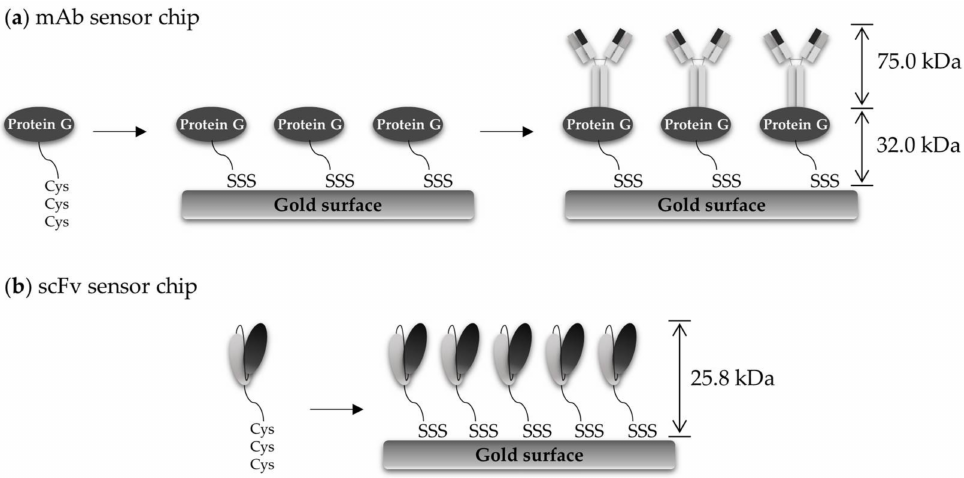
Figure 2. A schematic diagram of probe immobilization on surface plasmon resonance (SPR) chip for immuno-sensing of metallothionein derived from Oryzias javanicus (OjaMT). ( a ) Monoclonal antibodies were immobilized on gold surface via protein G-mediated interaction. ( b ) Recombinant scFv-Cys3 was directly immobilized on gold surface via thiol–gold